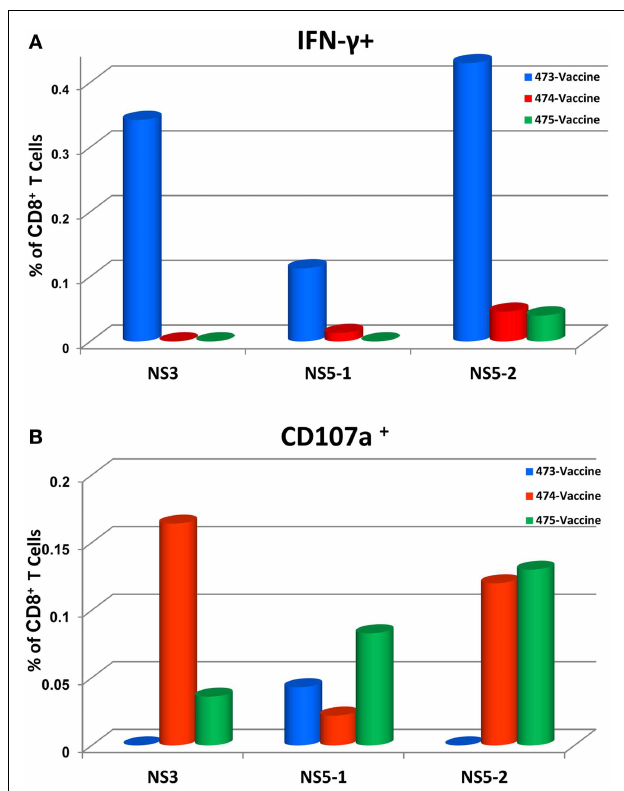
FIGURE 3 |Tetravalent dengue vaccine elicits CD8 + IFN- γ producingT cells that cross-react with NS3 and NS5 proteins of DENV-4 (A) and express the CD107a + marker (B) . Responses are shown as percentage of T cells from DENV-4 peptide arrays stimulated PBMCs with the background percentage of positiveT cells in medium only treated cells subtracted. Peptide arrays for NS5 were split into two pools; NS5-1 and NS5-2. At the time of PBMC testing, peptides arrays for DENV-4 NS1 protein were not available.